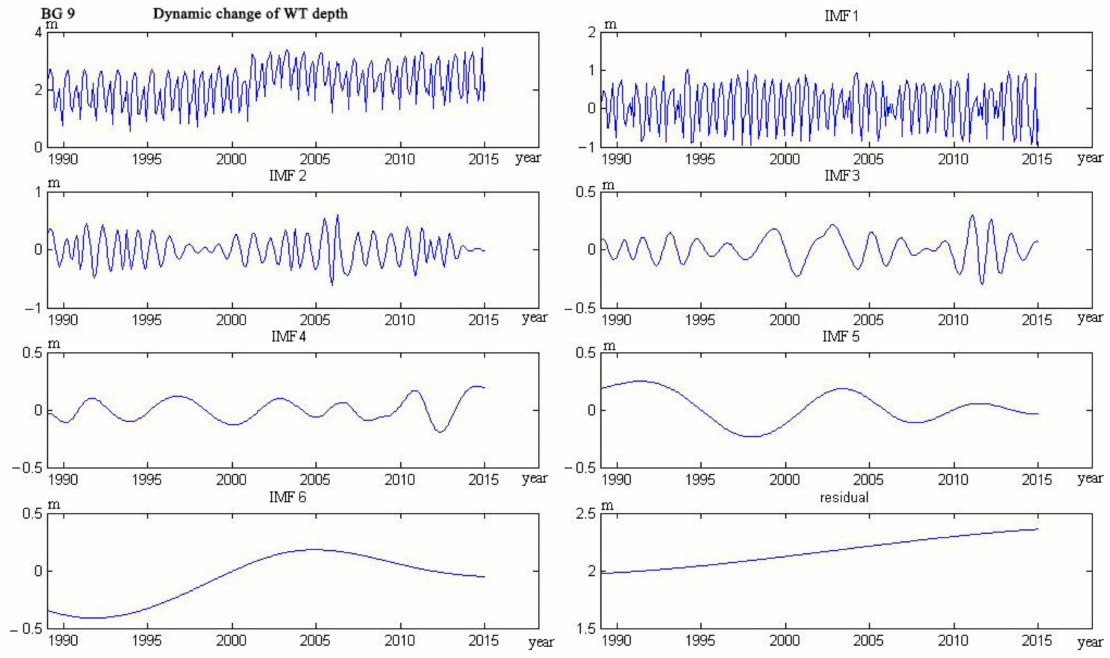
Figure A7. Decomposition of groundwater time series data of well BG9.